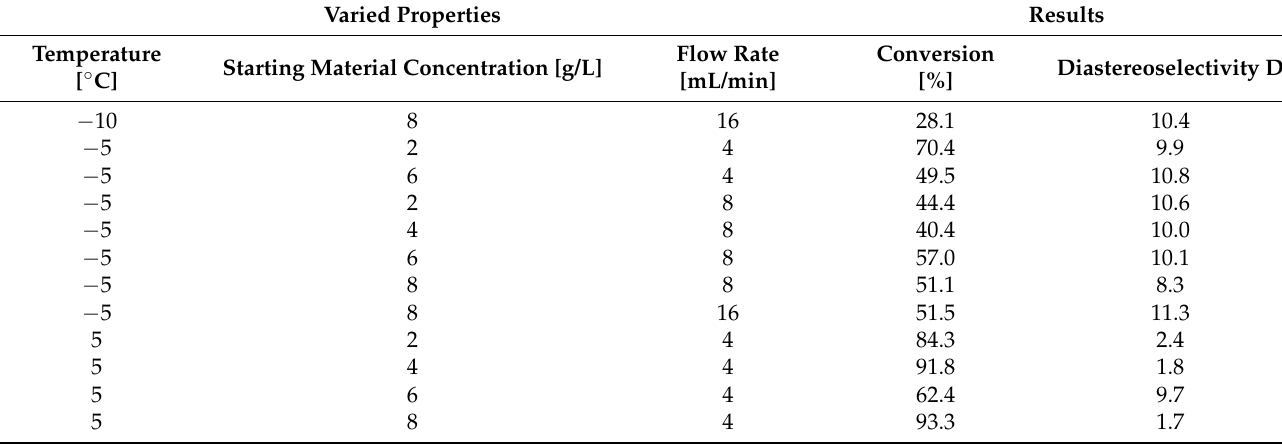
Table 1. Conditions for each experiment (temperature, starting material concentration, and flow rate), and response variables (conversion and diastereoselectivity). Due to the number of experiments and their length, single experiments are represented. For the conditions chosen as optimal ( − 5 ◦ C, concentration of 8 g/L, flow rate of 16 mL/min) n = 3, conversion = (56 ± 8)%, diastereoselectivity D = 11 ± 3. Measurement errors were